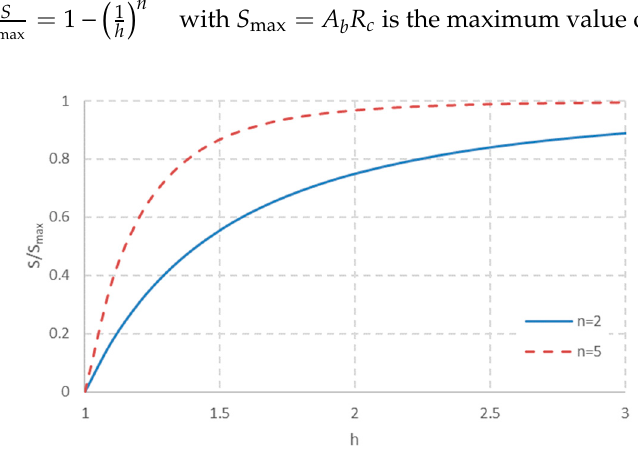
Figure 8. Relation between sediment import rate and the morphological state. h = 1 represents the morphological equilibrium without SLR. The import rate approaches the maximum value for large h .